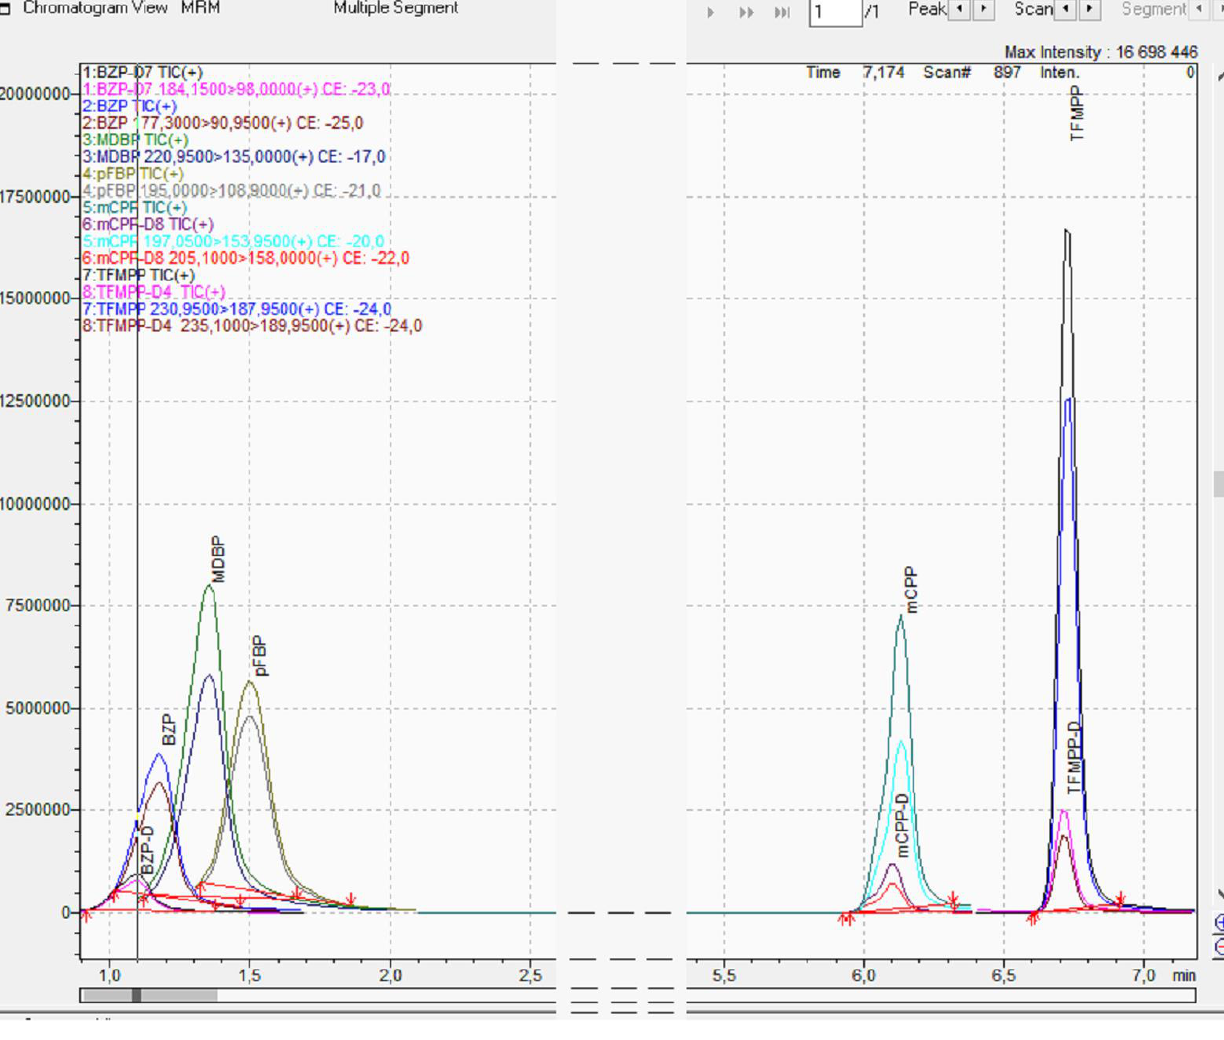
Figure 2. Liquid chromatography mass spectrometry (LC-MS) chromatogram (intensity vs. retention time) of piperazine derivatives and deuterated internal standards. Table 1. Multiple reaction monitoring (MRM) table in the LC-MS system used.